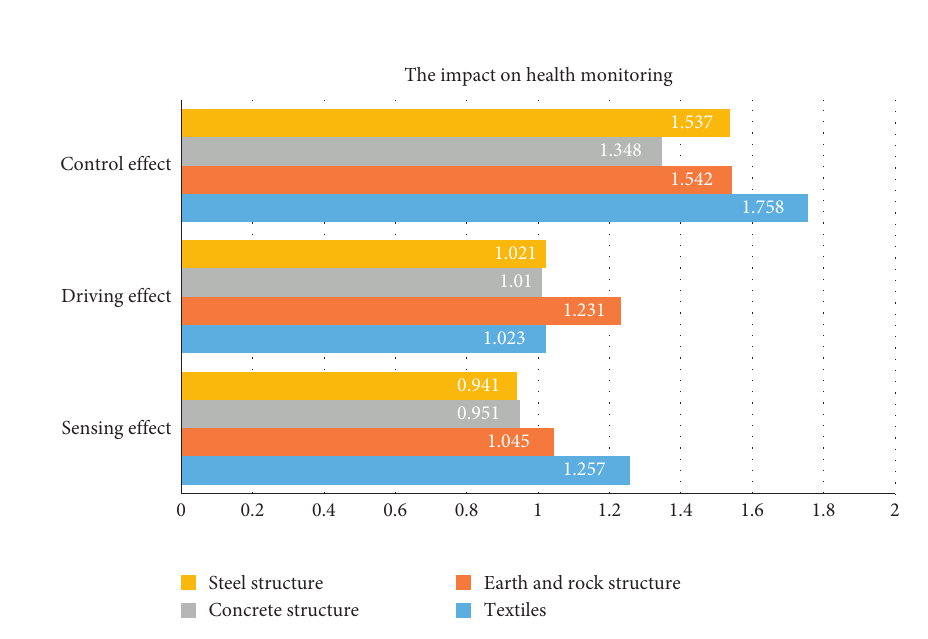
Figure 6: The impact of materials on health monitoring.